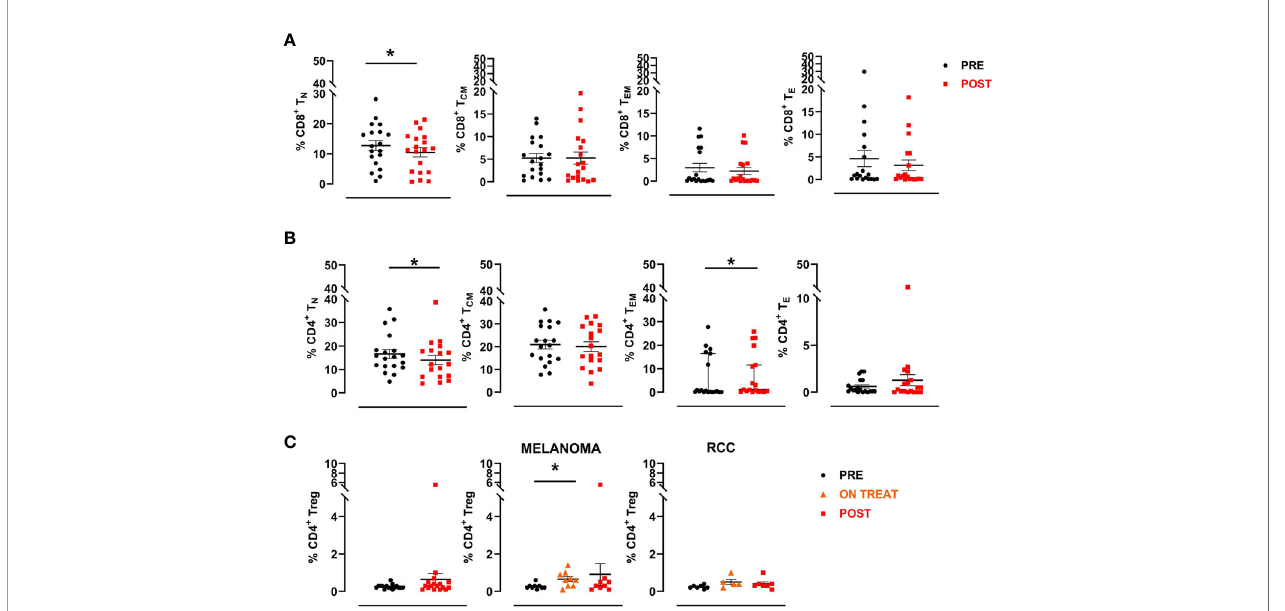
FIGURE 5 | CD8+ and CD4+ T cell subsets. A manual gating strategy was used to de fi ne T cell subsets within CD8+ and CD4+ lymphocytes. Brie fl y, naïve T cells were identi fi ed as CCR7+CD45RA+ (TN), central memory as CCR7+CD45RA- (TCM), effector memory as CCR7-CD45RA- (TEM) and effector as CCR7-CD45RA+ (TE). (A) Percentages of different CD8+ T cell subpopulations in pre- and post-treatment patient samples (n=19). (B) Percentages of different CD4+ T cell subpopulations in pre- and post-therapy patient samples (n=19). The black circular dots represent pre- therapy samples and the red squares represent post-therapy samples. (C) Scatter plots representing the percentage of Treg cells (CD3+CD4+CD25highFOXP3+) in the entire patient cohort (left panel), in MM patients (middle panel) and in RCC patients (right panel). The black circular dots represent pre-therapy samples, the orange triangles represent on-treatment samples (C3 or C4), the red squares represent post- therapy samples. Data represent individual values, mean (central bar) ± SEM (upper and lower bar). Statistical analysis was performed with the nonparametric Wilcoxon signed rank test; * p value <